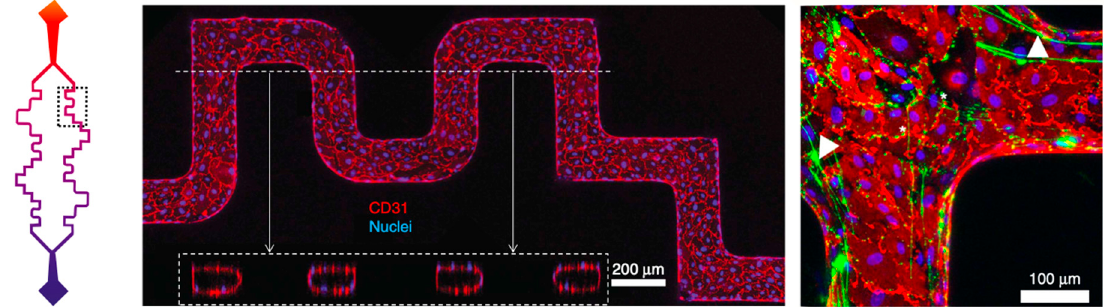
Figure 2. Schematic of pre-designed microvascular geometry (left) with confocal z-projection images (center) demonstrating CD31 (red) and nuclei (blue) staining in the microchannel wall. This geometry induces significant shear stress on the endothelium making them useful for evaluating its impact on vWF mesh formation (right) indicated with arrows and stained green. Adapted with permission from Zheng et al. [72].